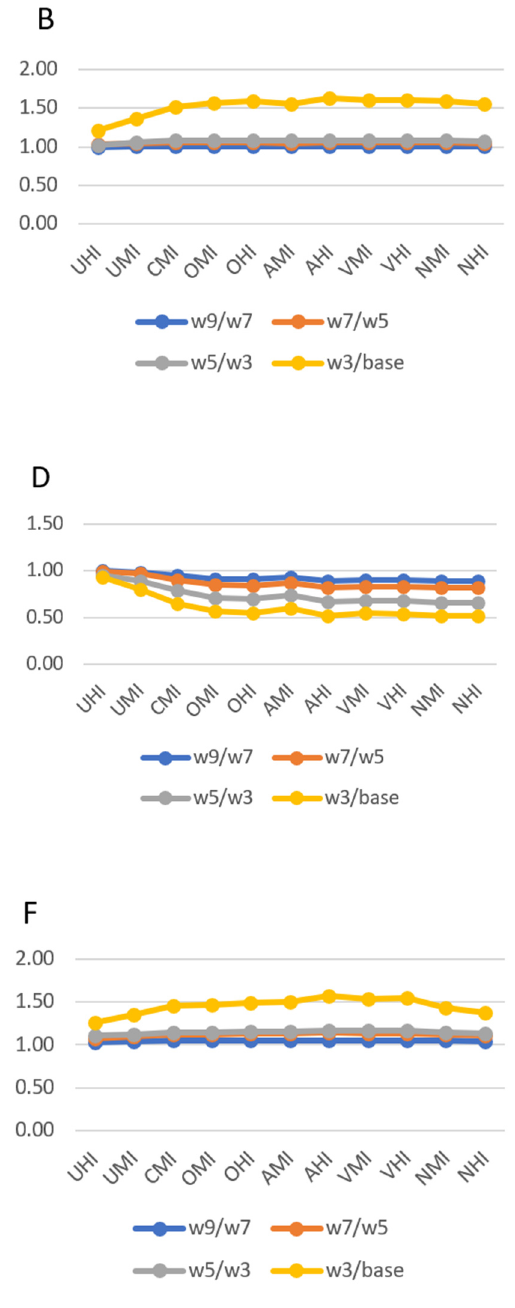
Figure 8. Average ratios between suitability indices of economic activities’ scenarios calculated using different weights for each landscape class (w9/w7: 9 on 7, w7/w5: 7 on 5, w5/w4: 5 on 3, w3/base: 3 on the baseline). ( A , B ): FARM scenario; ( C , D ): HOUS scenario; ( E , F ): COMM scenario. ( A , C , E ): supply-based suitability; ( B , D , F ): demand-based suitability; Descriptions of the landscape classes’ codes are reported in Table 1, scenarios’ codes in Table 2.